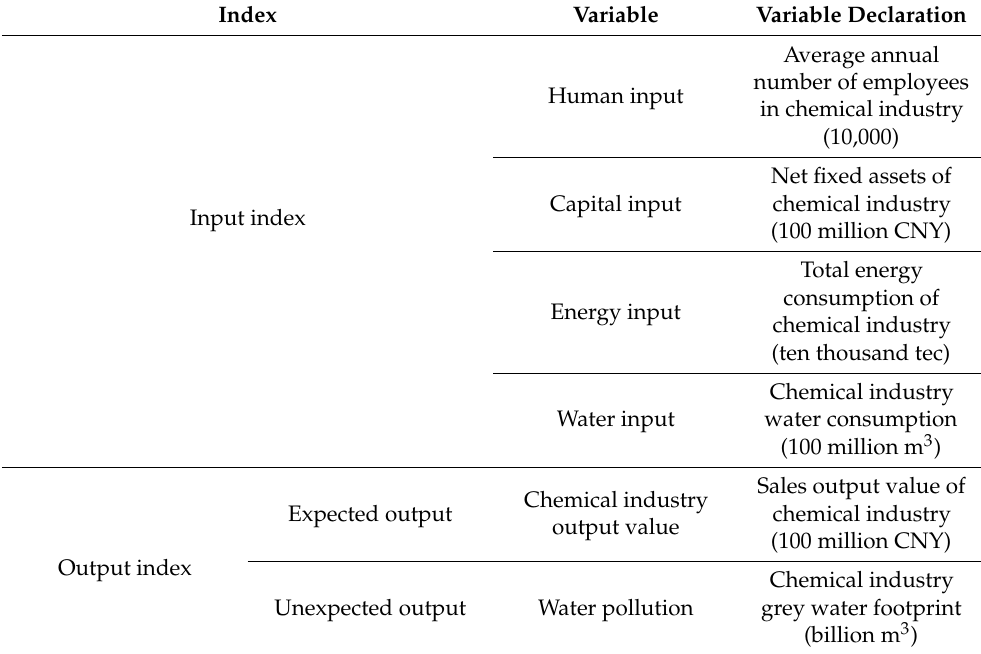
Table 1. Evaluation index system of green development efficiency of the chemical